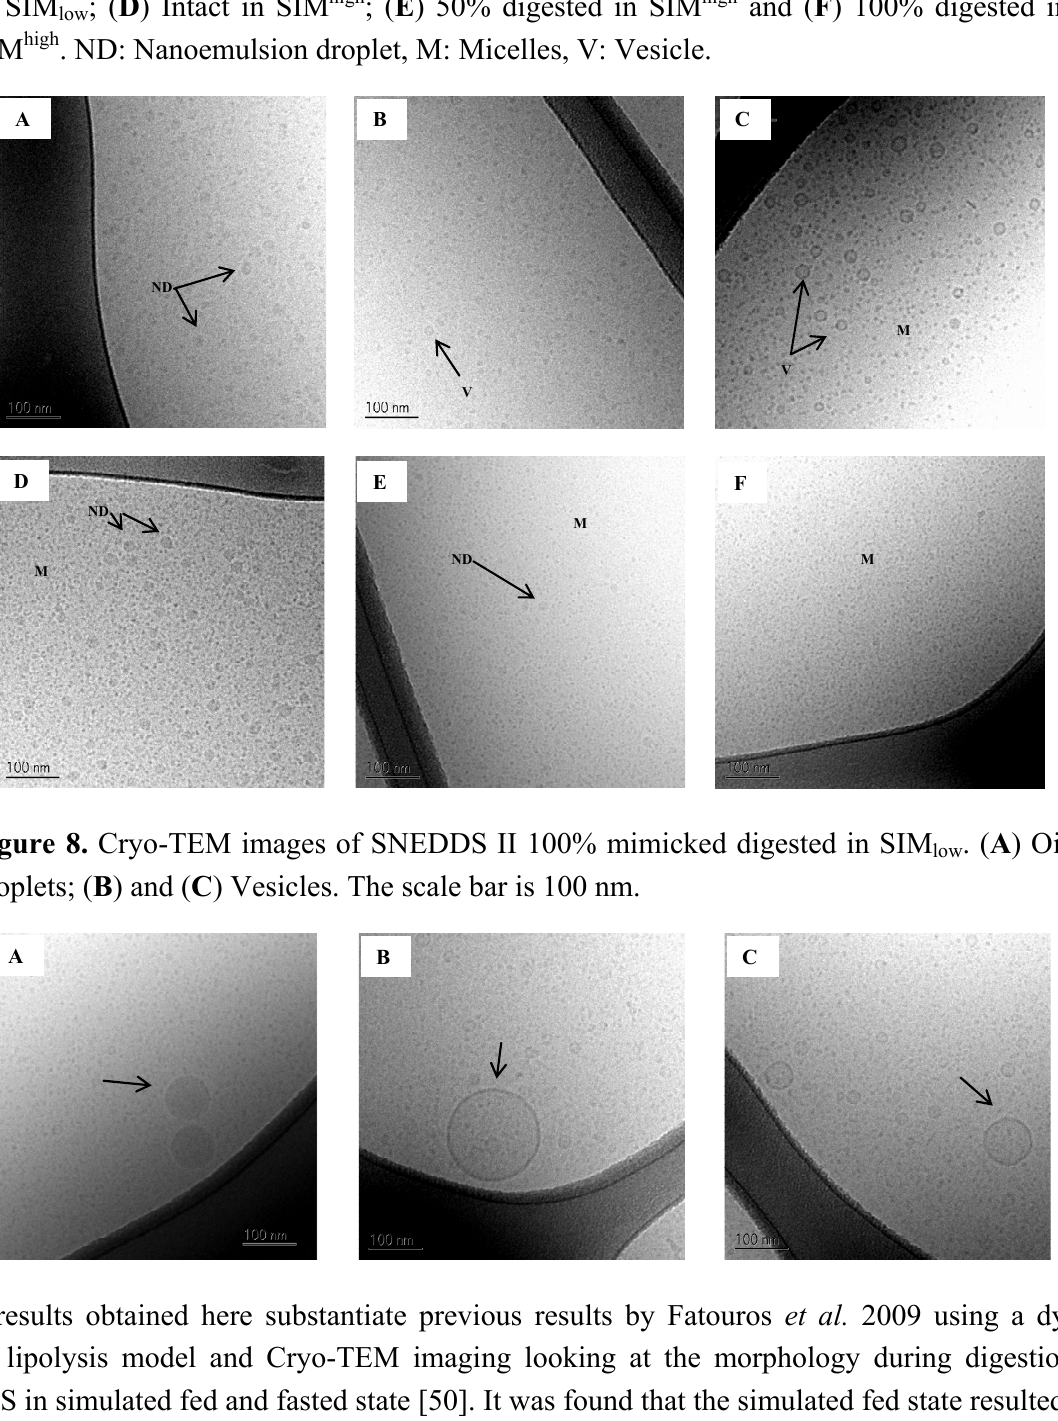
Figure 7. Cryo-TEM images of SNEDDS II intact and mimicked digested in intestinal simulated media. ( A ) Intact in SIM ; ( B ) 50% digested in SIM and ( C ) 100% digested low low in SIM ; ( D ) Intact in SIM high ; ( E ) 50% digested in SIM high and ( F ) 100% digested in low SIM high . ND: Nanoemulsion droplet, M: Micelles, V: Vesicle.